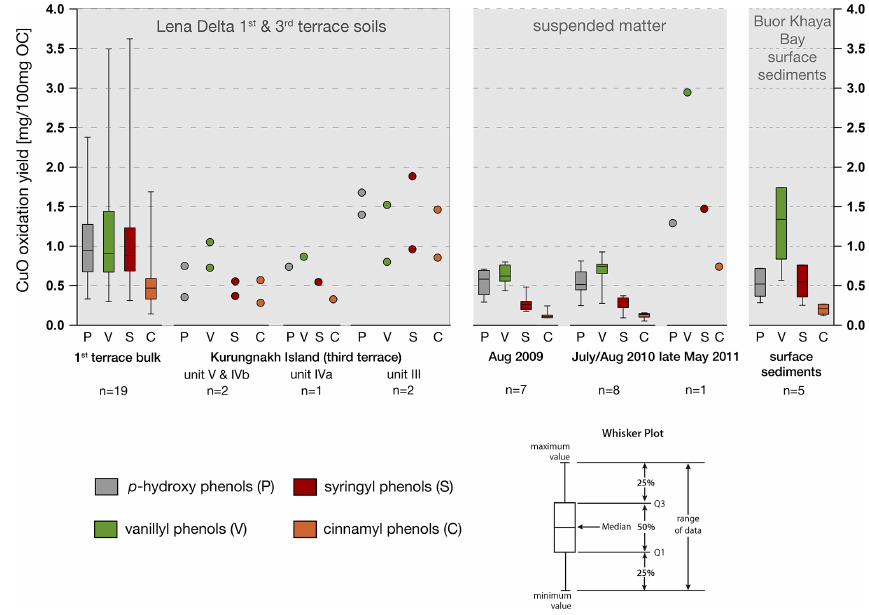
Figure 2. Carbon-normalized yields of phenols groups shown as box-and-whisker plots when the number of samples was large enough and as individual samples for smaller numbers.